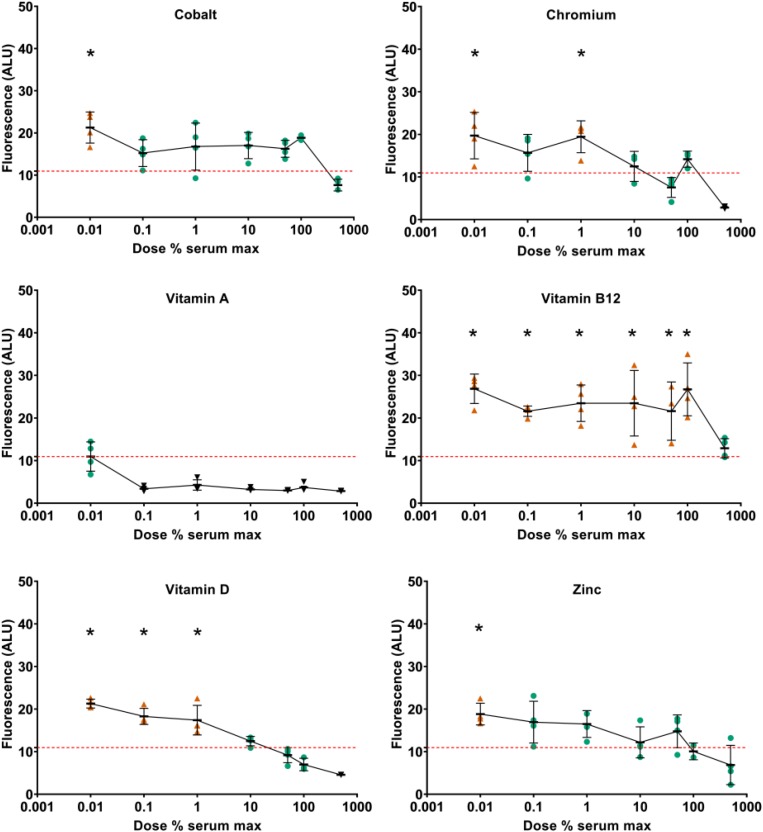
Effect of vitamin and mineral addition to TGFβ1 supplemented medium on metabolic activity. Cells were treated with resazurin, media was sampled at day 21 and assessed for fluorescence. All data were normalized against the conditioned media from pellets treated with basal chondrogenic media. The red dashed line indicates the fluorescence of the TGFβ1 supplemented basal medium. An orange triangle () and an * indicate greater than TGFβ1 supplemented basal medium; black triangles (▼) indicate lower vs. TGFβ1 supplemented basal medium, one-way ANOVA p < 0.05 Dunnett’s multiple comparison test. Conditions that were similar to TGFβ1 supplemented basal media are represented by a green circle ().